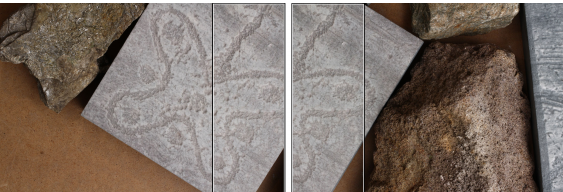
Figure 12: Typical pair of images acquired by the DSLR cameras